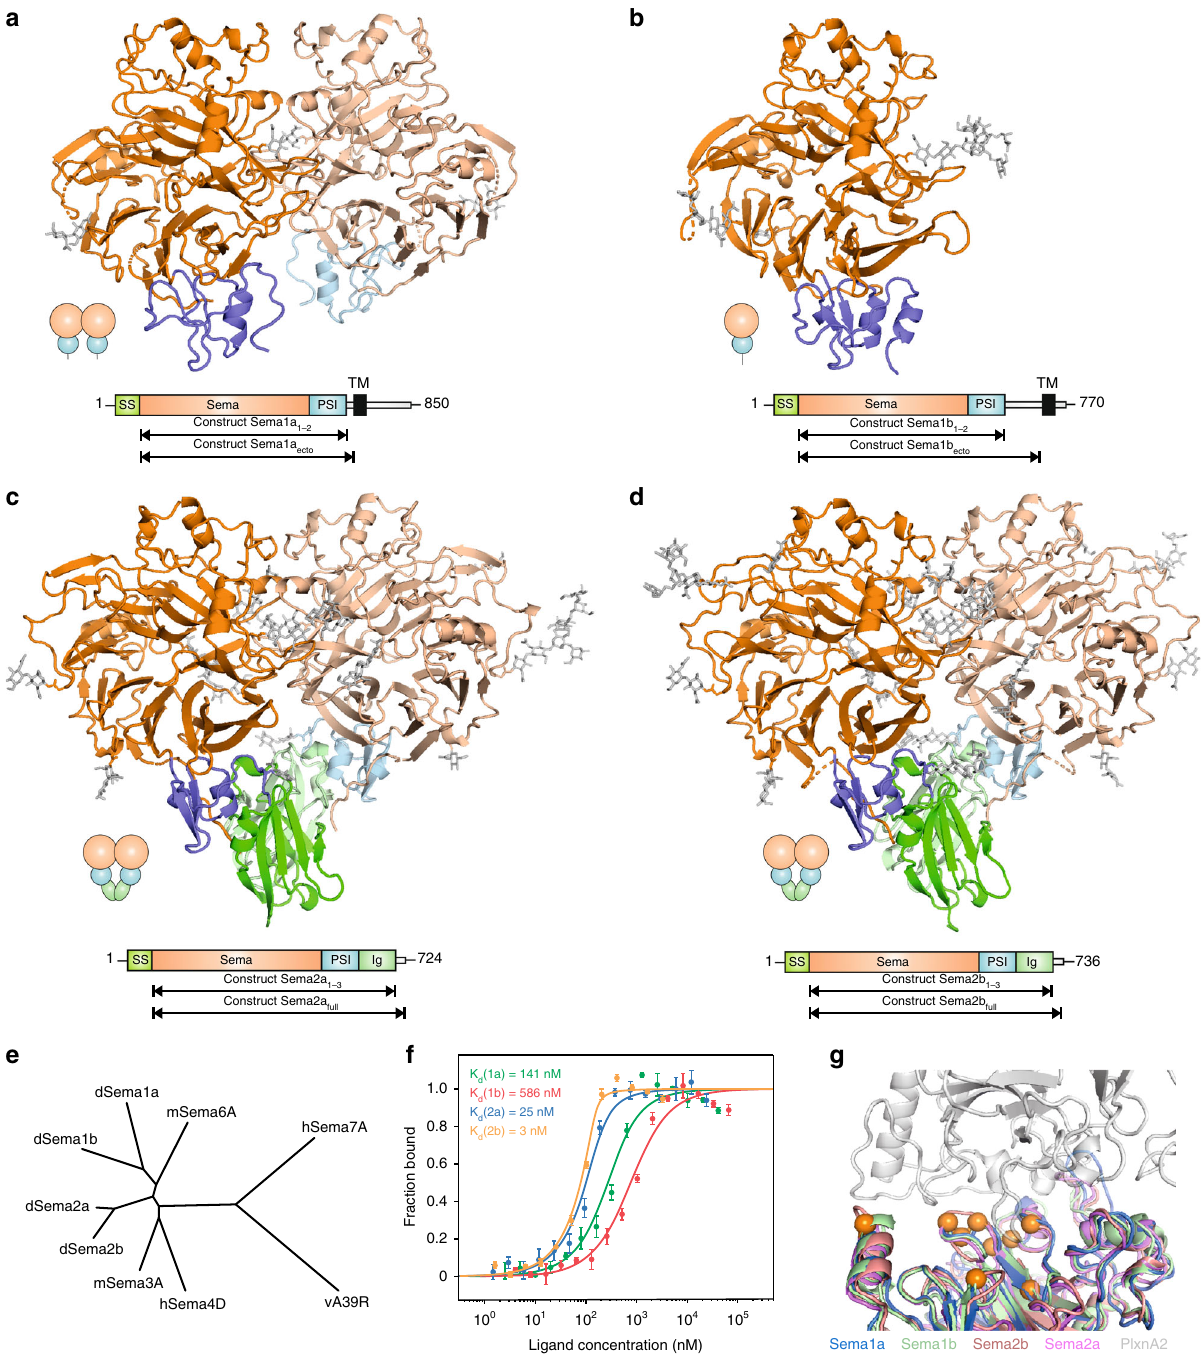
Fig. 1 Crystal structures of class 1 and class 2 semaphorins. a – d Ribbon representation of Sema1a 1 – 2 ( a ), Sema1b 1 – 2 ( b ), Sema2a 1 – 3 ( c ) and Sema2b 1 – 3 ( d ). N-glycans are shown in stick representation (grey). Chains A and B are coloured in dark and light shades, respectively. Schematic domain organizations of semaphorins are shown below the ribbon representation. SS, signal sequence; TM, transmembrane region. e Structure-based phylogenetic tree of the sema domains constructed from all available structures of sema domains (mSema3A pdb code 1q47, hSema4D pdb code 1olz, mSema6A pdb code 3okw, hSema7A pdb code 3nvq, vA39R pdb code 3nvn, Sema1a, Sema1b, Sema2a and Sema2b described here). The phylogenic tree was calculated with SHP 55 . f Microscale thermophoresis binding experiment for PlexA 1 – 4 -mVenus and Sema1a ecto -Fc (green) or Sema1b ecto (red), and PlexB 1 – 4 -mVenus and Sema2a full (blue) or Sema2b full (orange). Error bars represent s.d. of three technical replicates. Source data are provided as a Source Data fi le. g The putative binding site for plexin was identi fi ed by superposition of Drosophila semaphorins with mouse Sema6A in complex with PlxnA2 (white). The architecture of the putative binding site is very similar among Drosophila semaphorins. Class-dependent binding speci fi city to plexin receptors is probably determined by nine residue substitutions (orange) that are spatially spread throughout the putative interface. The structures were superposed via their sema